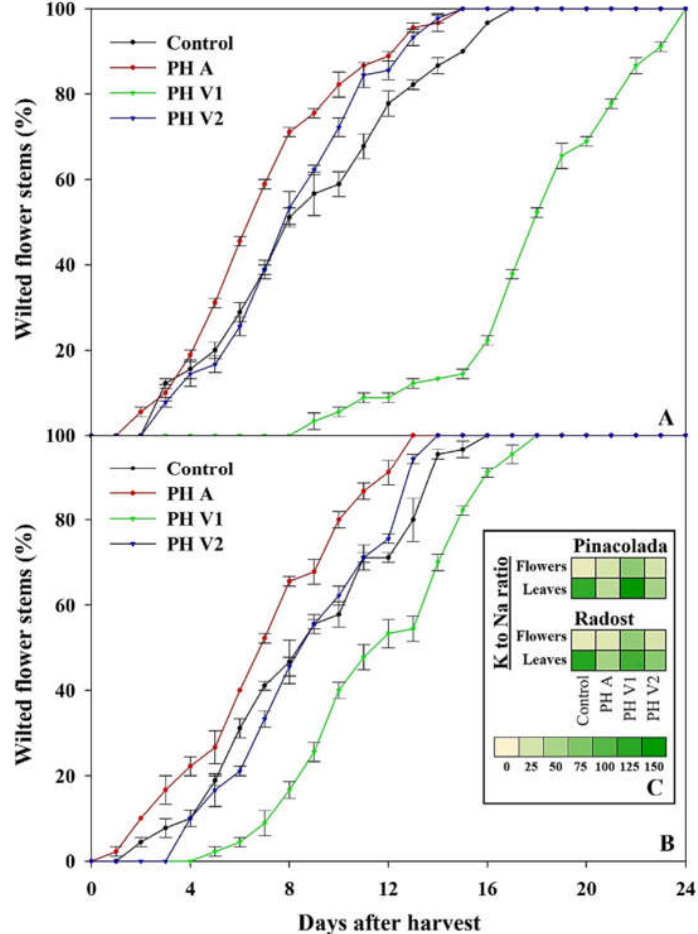
Figure 2. Flower stem wilting in Pinacolada ( A ) and Radost ( B ) cultivars, as affected by the biostimulant treatments (untreated control, one animal PH (PH A, Hicure ® ), or two vegetal PHs (PH V1, Trainer ® and PH V2, Vegamin ® )). In the figure inset ( C ), a heat map of the K-to-Na ratio in the flowers and leaves of Pinacolada and Radost cultivars under the different treatments. The heat map was visualized using a yellow-to-green false incremental color scale.